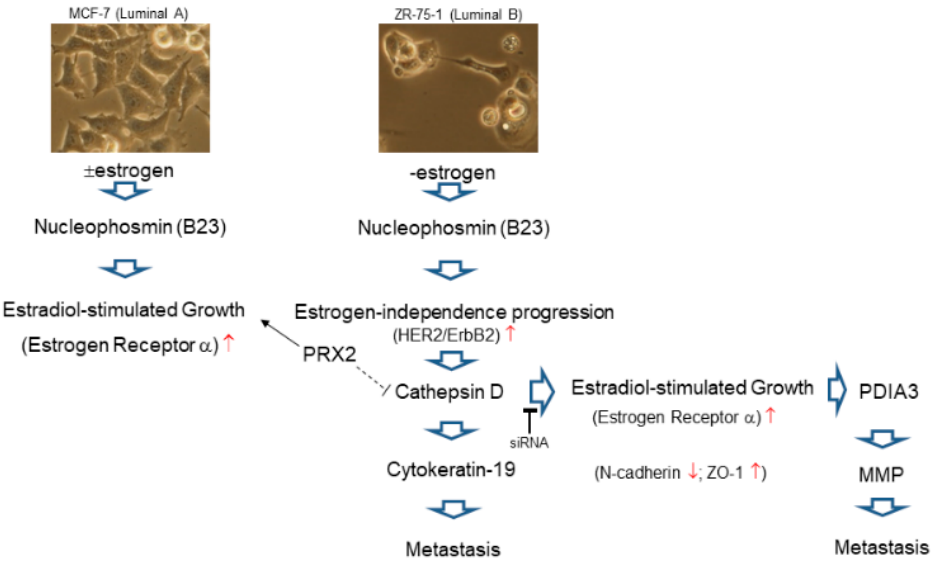
Figure 4. Schematic diagram of cathepsin d -mediated regulation in ECM and EMT, eventually resulting in breast cancer relapse and metastasis (red upward arrows mean increase and red downward arrows indicate decrease).